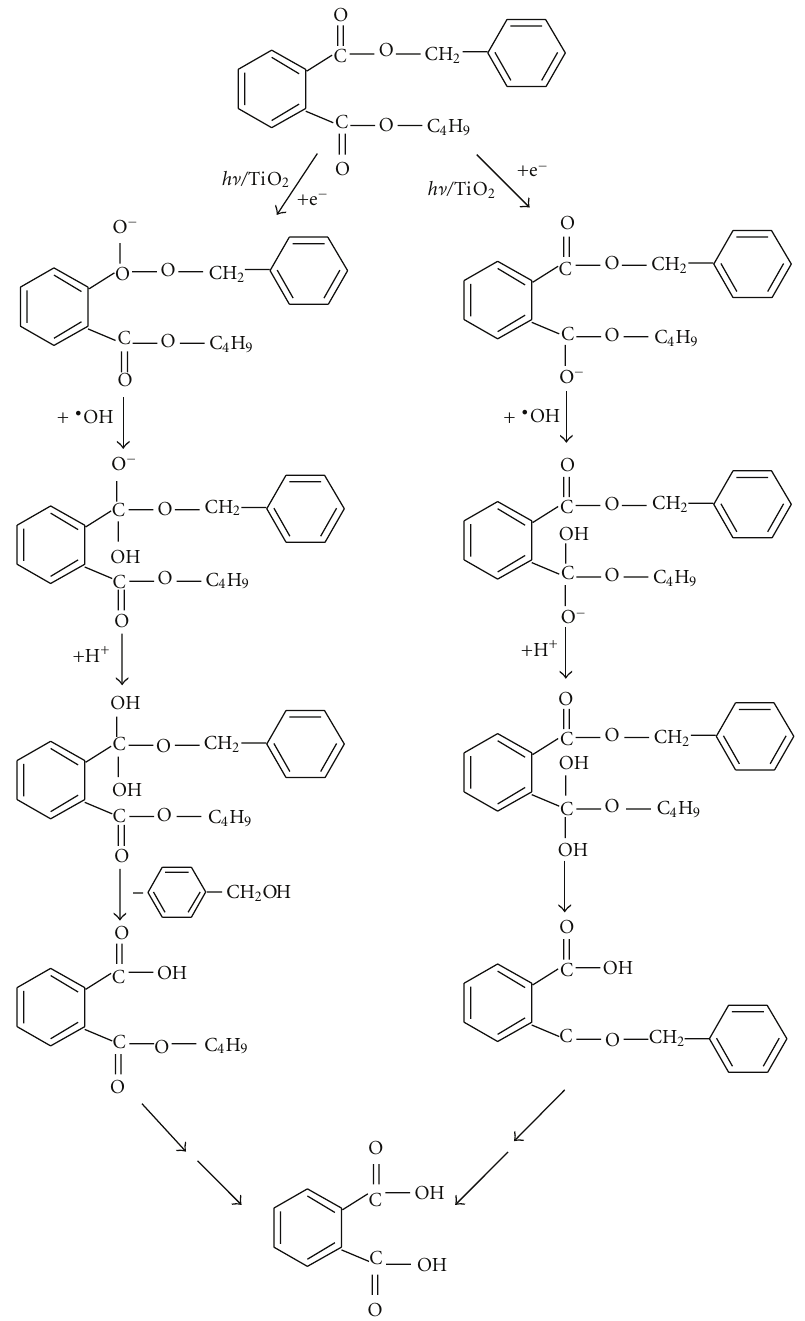
Figure 6: Photocatalytic degradation scheme for BBP